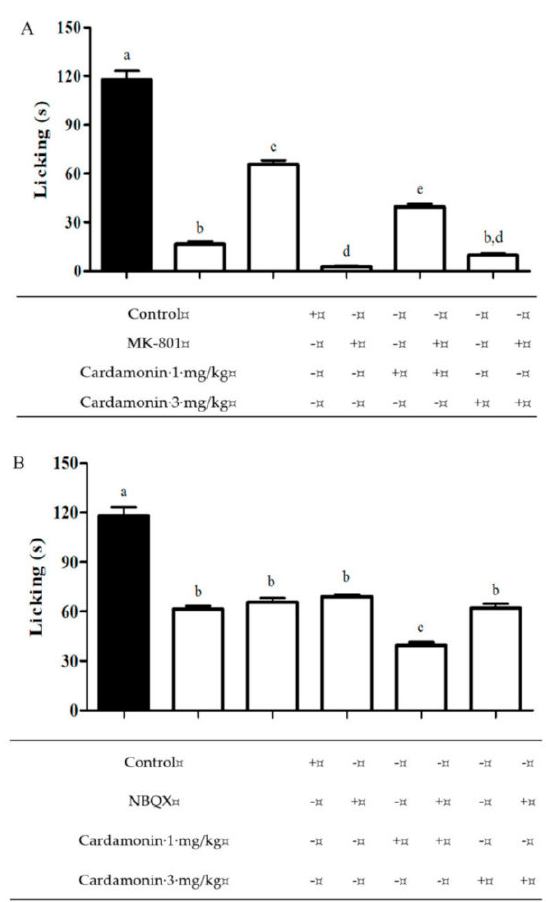
Figure 3. E ff ect of MK-801 (0.3 mg / kg; i.p.) (panel A ) and NBQX (3 mg / kg; i.p.) (panel B ) on antinociception caused by cardamonin (1 and 3 mg / kg; i.p.) in glutamate-induced paw licking